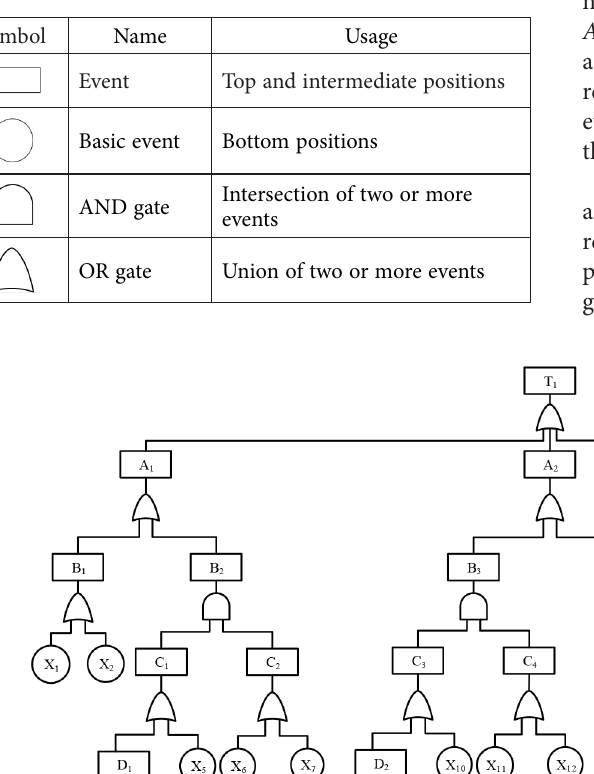
Table 2. Symbolic notations used in the fault tree